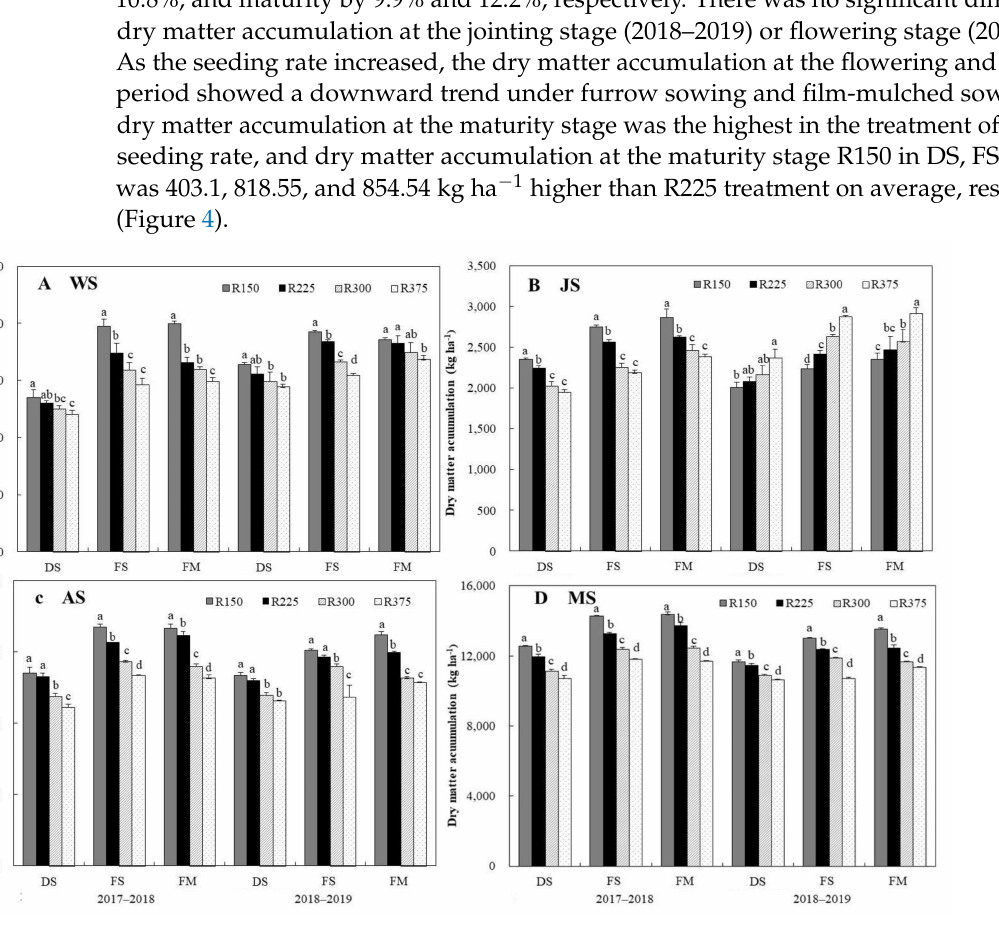
Figure 4. Effect of planting patterns and seeding rate on dry matter amount at different growing stages of wheat. ( A ) Dry matter accumulation at WS. ( B ) Dry matter accumulation at JS. ( C ) Dry matter accumulation at AS. ( D ) Dry matter accumulation at MS. Different small letters indicate that means within a column are significantly different ( p ≤